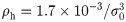
Dependence of shell size on the driving force for pentamer addition.The mean shell size (number of hexamers + 12 pentamers) is shown as a function of the pentamer/hexamer stoichiometry ratio ρp/ρh for indicated values of the pentamer/hexamer affinity ratio εPH/εHH for simulations with cargo. Results from empty shell simulations are also shown for εPH/εHH = 1.3. Snapshots of typical assembly morphologies for indicated parameter values are shown around the plot. In these simulations the hexamer concentration, hexamer-hexamer affinity, and hexamer-shell affinity, and bending modulus were fixed at ρh=1.7×10-3/σ03, εHH = 1.8, εCC = 1.65, εSC = 8.5, and κs = 10kBT.